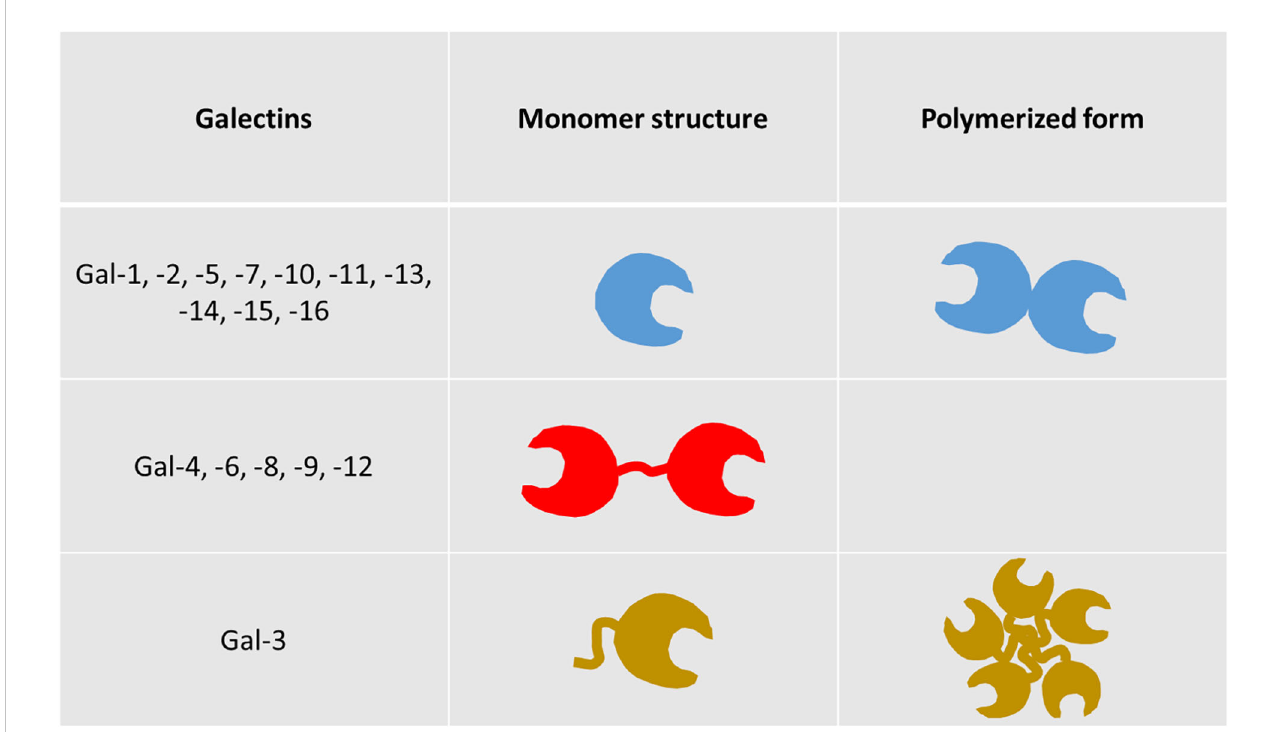
FIGURE 1 Structural types of galectins. Galectins are categorized in three distinct groups, based on their structure. The fi rst group contains members bearing a single carbohydrate recognition domain (CRD), while the second comprises of members with two CRDs, connected by a short peptide sequence (tandem repeat-type galectins). Galectin-3 is the sole member of the third group, as it combines a single CRD with a unique amino-terminal non-lectin domain (chimera-type galectin). Members of groups 1 and 3, bearing a single CRD, are able to polymerize, exhibiting new and distinct functional features compared to their monomeric forms